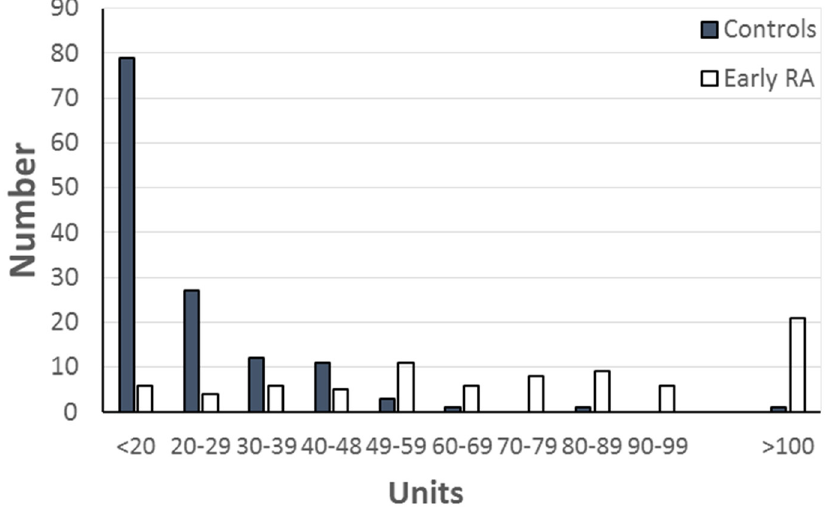
Figure 1. Distribution of levels of anti ‐ CB10 in 82 patients with early RA and 136 controls. The upper limit of normal was 48 units, based on ROC plot analysis of the controls and 52 patients with long ‐ standing RA. Anti ‐ CB10 in the six positive controls were in two sera from patients with SLE (52 and 54 units), two biochemistry discards from patients with unspecified diagnoses (60 and 87 units), and two blood donors (54, 130 units).